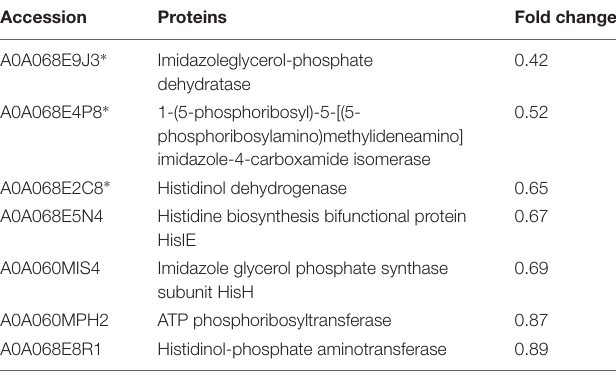
TABLE 1 | Changes in the expression of the proteins involved in histidine biosynthesis after azithromycin treatment.